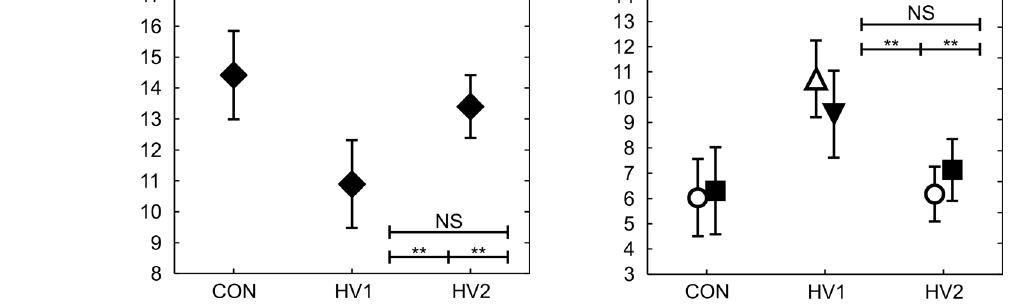
Fig.11 Peak range of motion of the pelvis (in deg) in the transversal plane